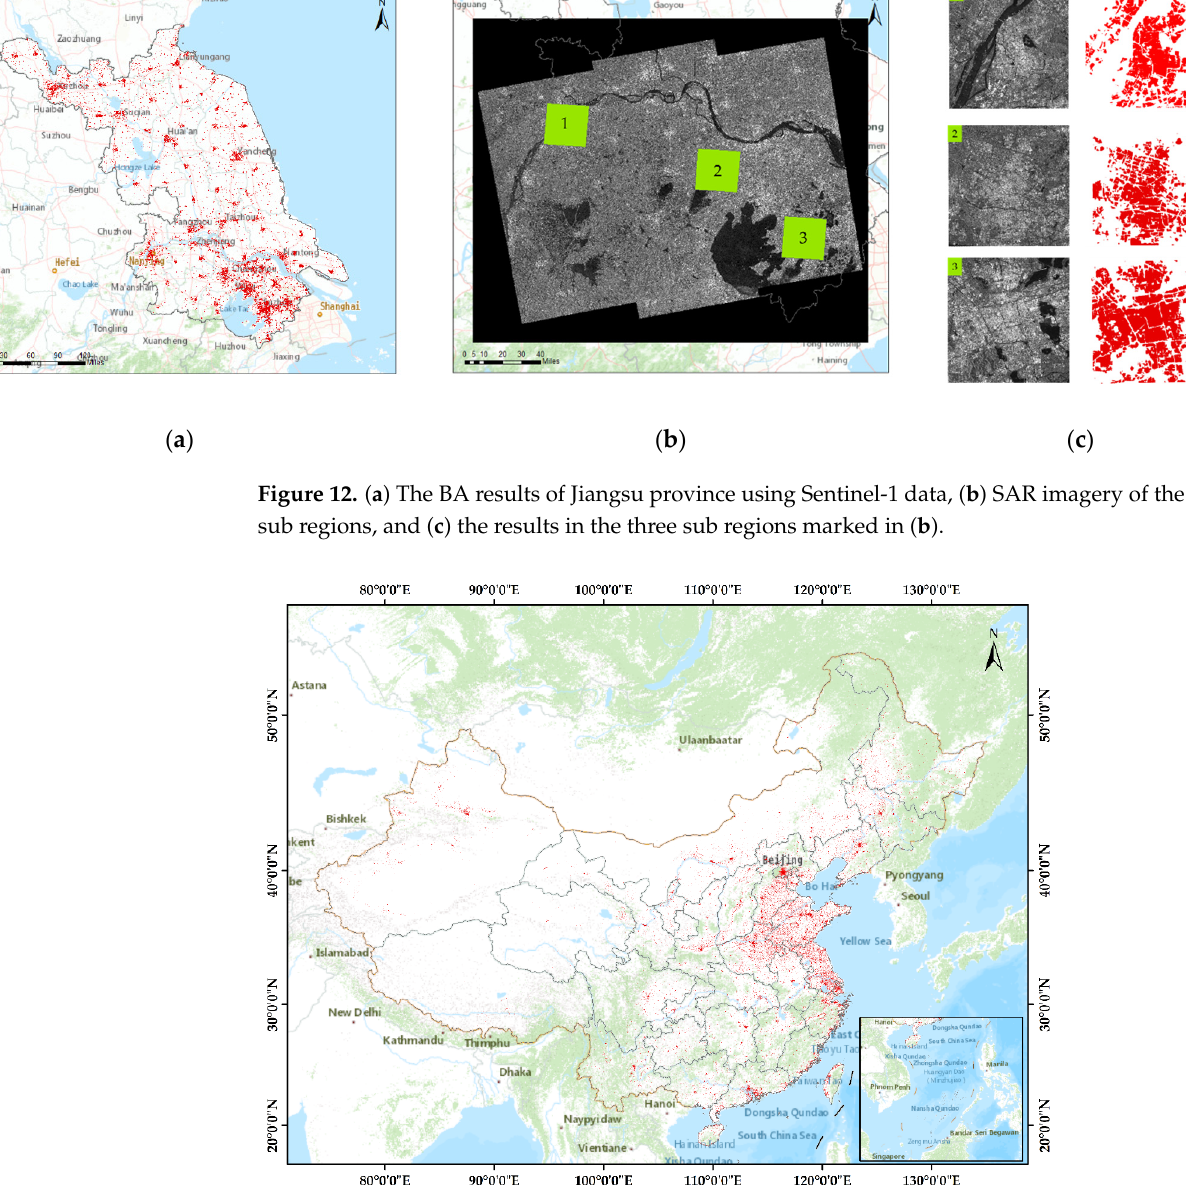
Figure 13. The BA map of China in 2020. The red represents built-up areas.